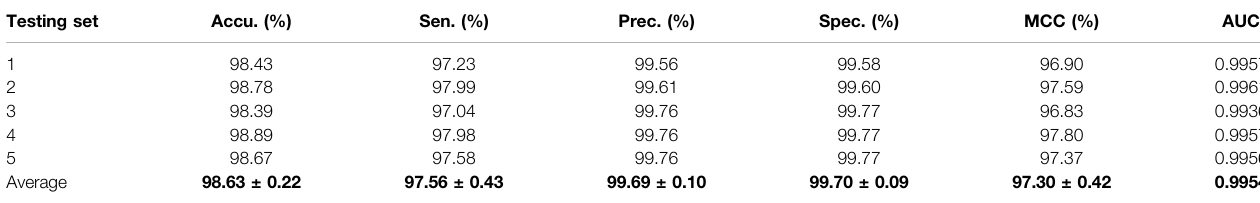
TABLE 1 | The fi vefold cross-validation results achieved on the A. thaliana dataset using the proposed CPIELA method. Testing set Accu.